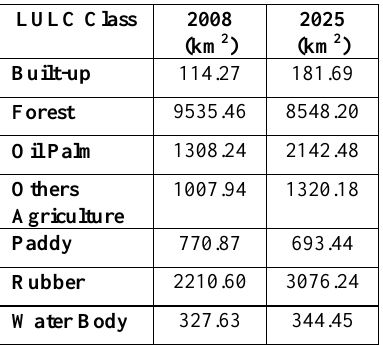
Table 7. Projected LULC area year 2008 and